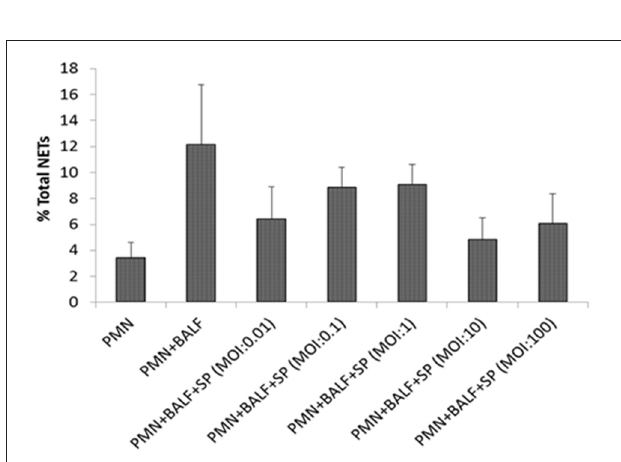
FIGURE A2 | Quantification of NETs degradation by S. pneumoniae in vitro . Mouse bone marrow-derived neutrophils (PMN) served as negative control. Neutrophils were stimulated for 2h with BALF from influenza-infected mice (PMN + BALF), which were then incubated with S. pneumoniae 19F (PMN + BALF + SP) at MOI of 0.01, 0.1, 1, 10, and 100 for 2h. After incubation, the remaining NETs were quantified as previously described. Compared with the PMN + BALF group, infection with different MOI of bacteria resulted in modest reduction of total NETs, implying only partial degradation of NETs by S. pneumoniae 19F. Values represent the means ± SE of at least 3 independent experiments. The P -values were not significant between the PMN + BALF + SP groups versus the PMN + BALF group.